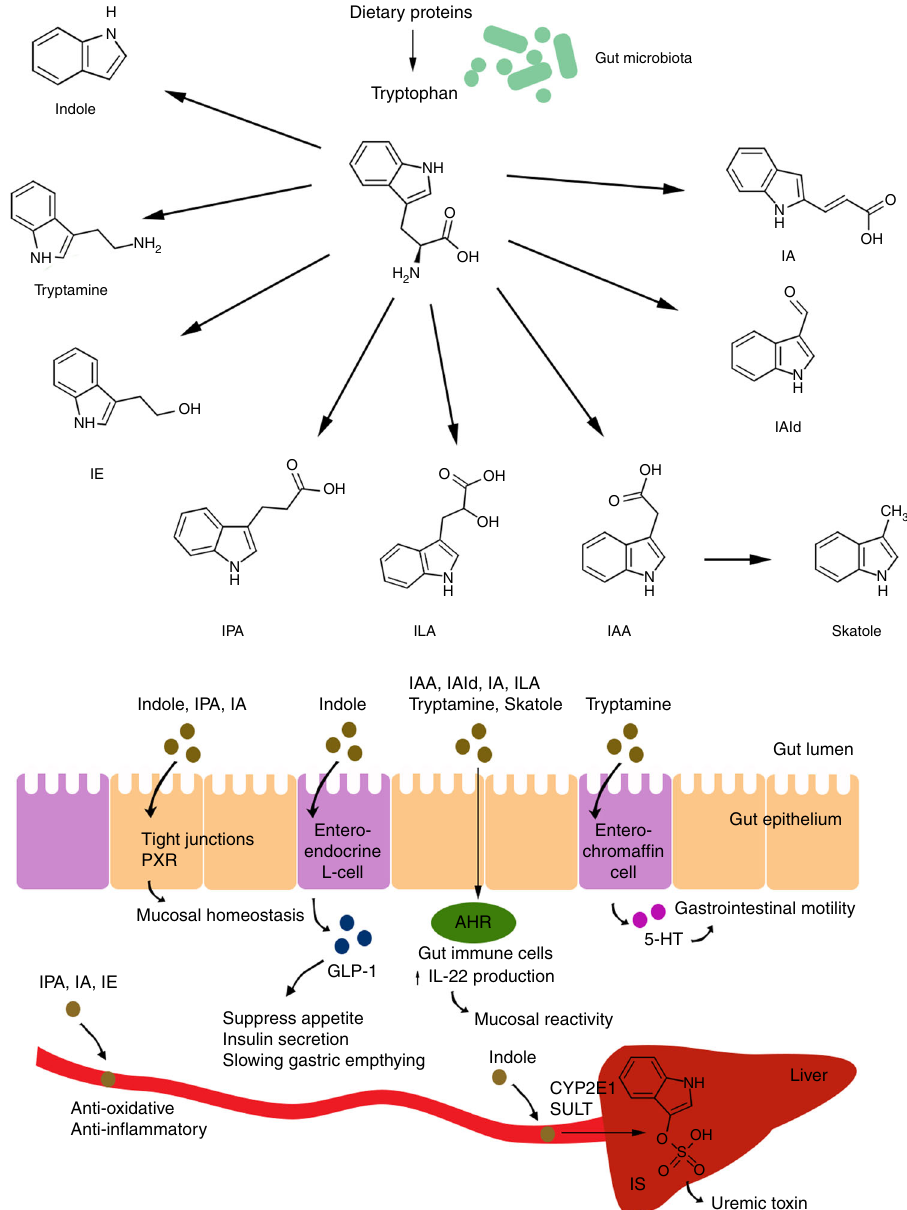
Fig. 1 Mechanisms of action of microbial tryptophan catabolites on host physiology. Degradation of dietary proteins leads to the release of tryptophan, which is converted into various catabolites by the gut microbiota. The tryptophan catabolites include indole, tryptamine, indoleethanol (IE), indolepropionic acid (IPA), indolelactic acid (ILA), indoleacetic acid (IAA), skatole, indolealdehyde (IAld) and indoleacrylic acid (IA) and may affect host physiology in numerous ways. Indole, IPA and IA affect mucosal homeostasis by decreased intestinal permeability possibly mediated by the pregnane X receptor (PXR). Indole induces the release of glucagon-like peptide 1 (GLP-1) in enteroendocrine L-cells. GLP-1 is known to suppress appetite, insulin secretion and to slow gastric emptying. Several tryptophan catabolites act on the aryl hydrocarbon receptor (AHR) found in intestinal immune cells and thereby alter innate and adaptive immune responses in a ligand-speci fi c fashion (e.g. IAld induces increased production of interleukin-22 (IL-22) via AHR activation). Tryptamine induces the release of 5-hydroxytryptamine (5-HT, serotonin) by enterochromaf fi n cells. 5-HT stimulates gastrointestinal motility by acting on enteric nervous system neurons. Tryptophan catabolites are absorbed through the intestinal epithelium and enter the bloodstream where some (e.g. IPA, IE, IA) have anti-oxidative and anti-in fl ammatory effects, whereas indoxyl-sulfate (IS), which is produced in the liver from indole by the actions of CYP2E1 and sulfotransferases (SULT), has cytotoxic effects in high